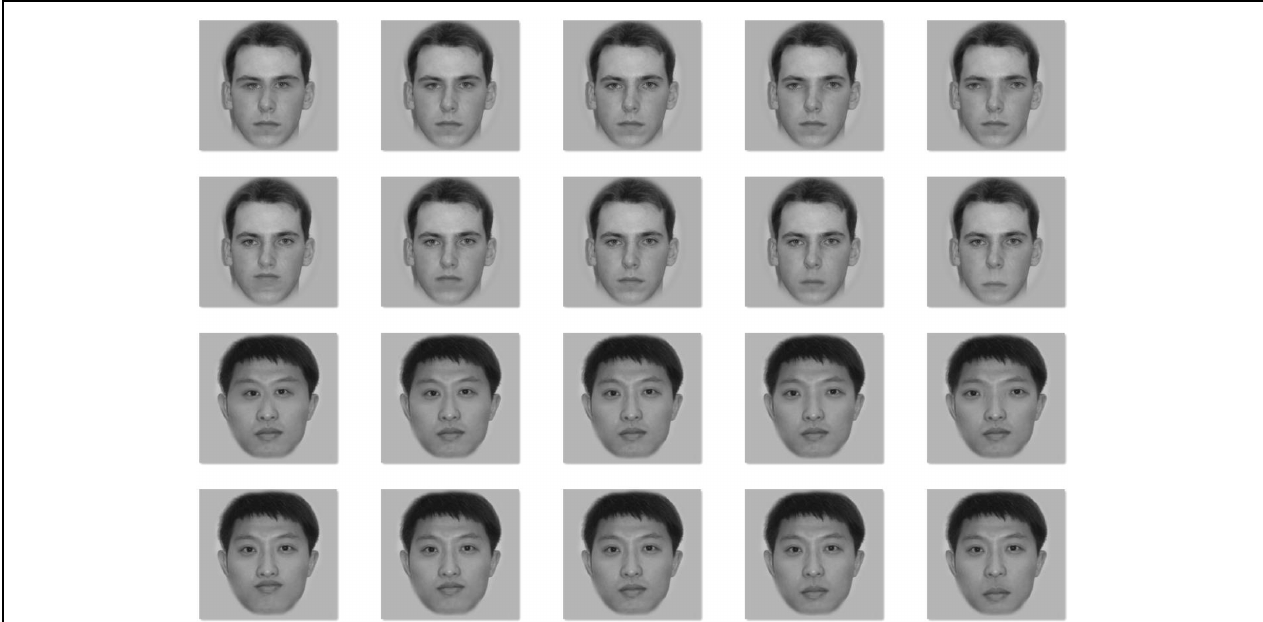
FIGURE 1 | Examples of spacing change between the two eyes (Rows 1 and 3) or between the nose and mouth (Rows 2 and 4) in a Caucasian face (Rows 1 and 2) and an Asian face (Rows 3 and 4). The middle face of each row is the original face upon which the manipulations were made. The leftmost face has the distance between eyes or between nose and mouth 10 pixels smaller than the original (the